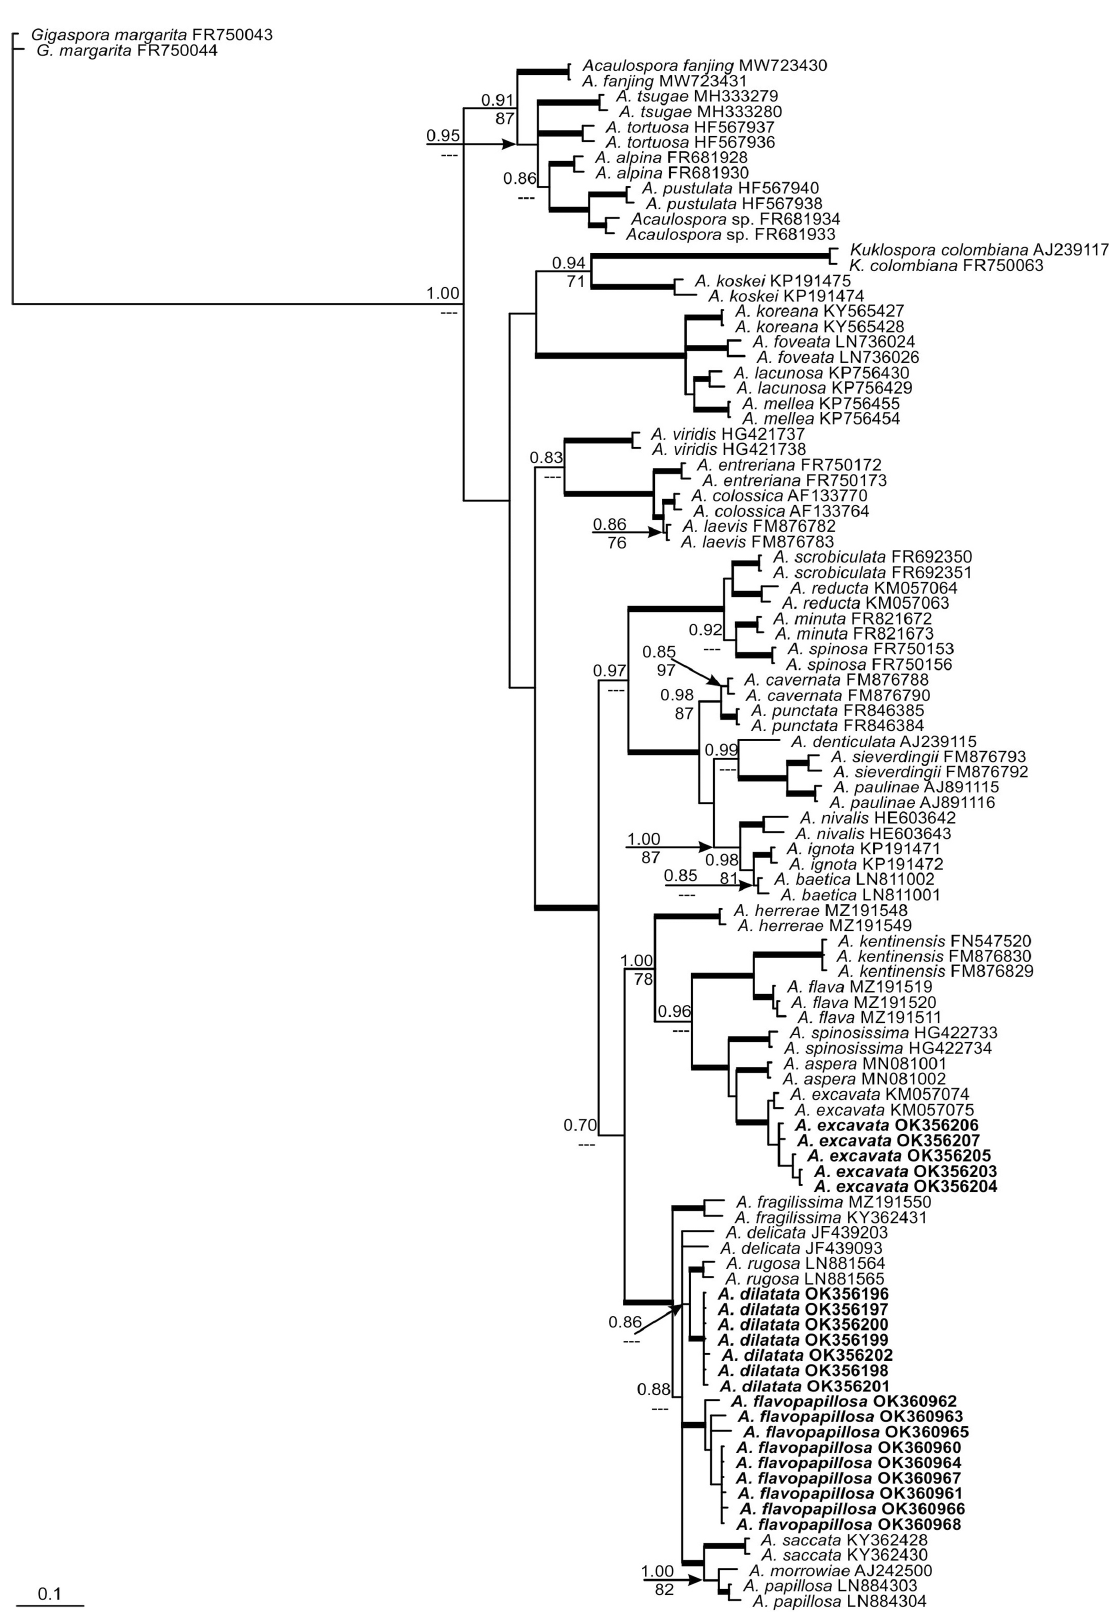
Fig. 7: Phylogenetic tree of the Acaulosporaceae obtained by analysis from sequences of the ITS region of the rDNA from different Acaulospora spp. sequences are labeled with their database accession numbers. Support values (from top) are from Bayesian inference − BI (performed with two runs over 3 × 10 6 generations, with a sample frequency of 300 and a burnin value of 25%) and maximum likelihood – ML (performed with 1,000 bootstrap), respectively. The GTR + G model was used in both analyses. Sequences obtained in this study are in boldface. Only support values of at least 70% are shown. Thick branches represent clades with more than 90% of support in all analyses. The tree was rooted by Gigaspora margarita